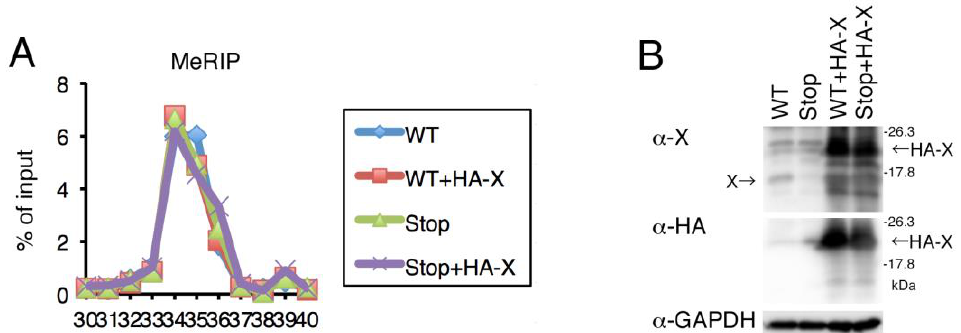
Figure 6. Effect of HBx on HBV RNA methylation. ( A ) HepG2/NTCP cells were co-transfected with pUC1.2xHBV (WT) or its HBx-Stop mutation (Stop) together with HA-tagged HBx expression vector or its empty control vector. After 2 days, RNA was isolated and subjected to MeRIP analysis, which was followed by qRT-PCR. The level of precipitated RNA was plotted according to input level. ( B ) Protein level of HBx. Western blotting was carried out using anti-HBx, -HA, and -GAPDH antibod- ies.